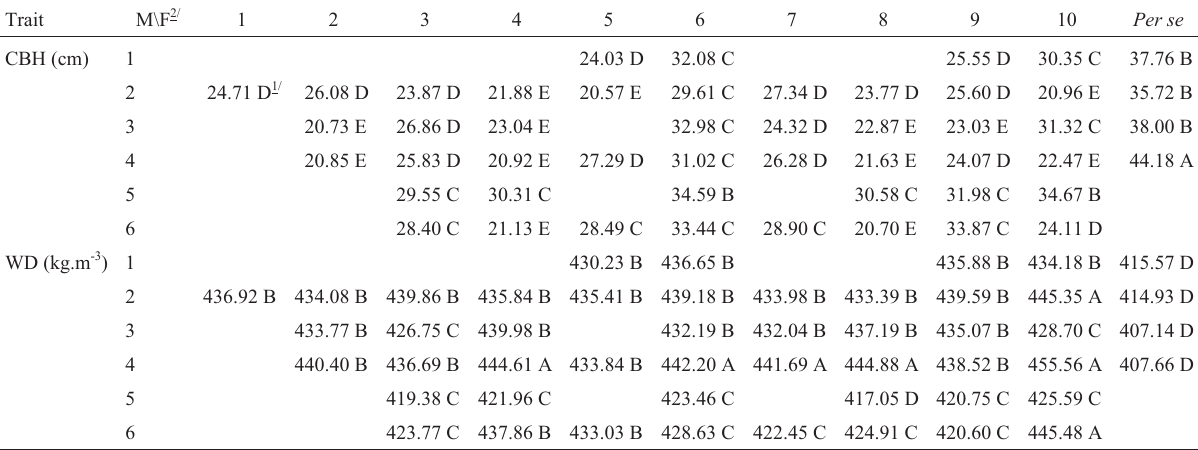
Table3 -Meansofthehybridsandclonesusedascontrolsforcircumferenceatbreastheight(CBH)andwooddensity(WD)obtainedintheevaluationof two-year-old trees from diallel crossings of Eucalyptus globulus clones (fathers) and elite clones (mothers), in the joint analysis.